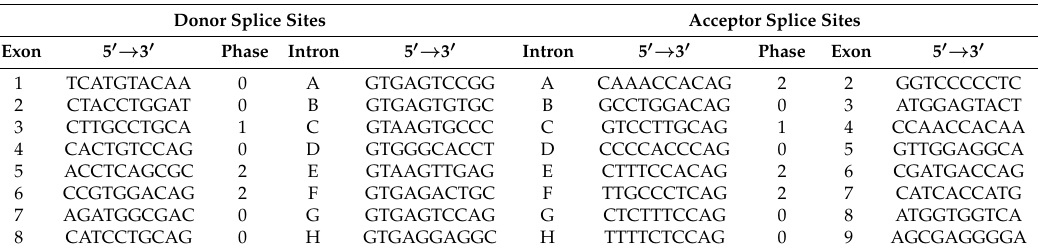
Table 5. Characteristics of exon-intron junctions within the hPAG-L/pep